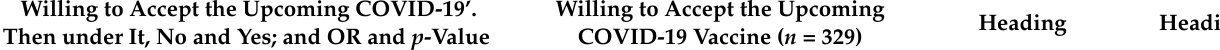
Table 2. Healthcare workers’ COVID-19 Vaccine Attitudes Scale items as predictors of accepting the COVID-19 vaccine. Willing to Accept the Upcoming